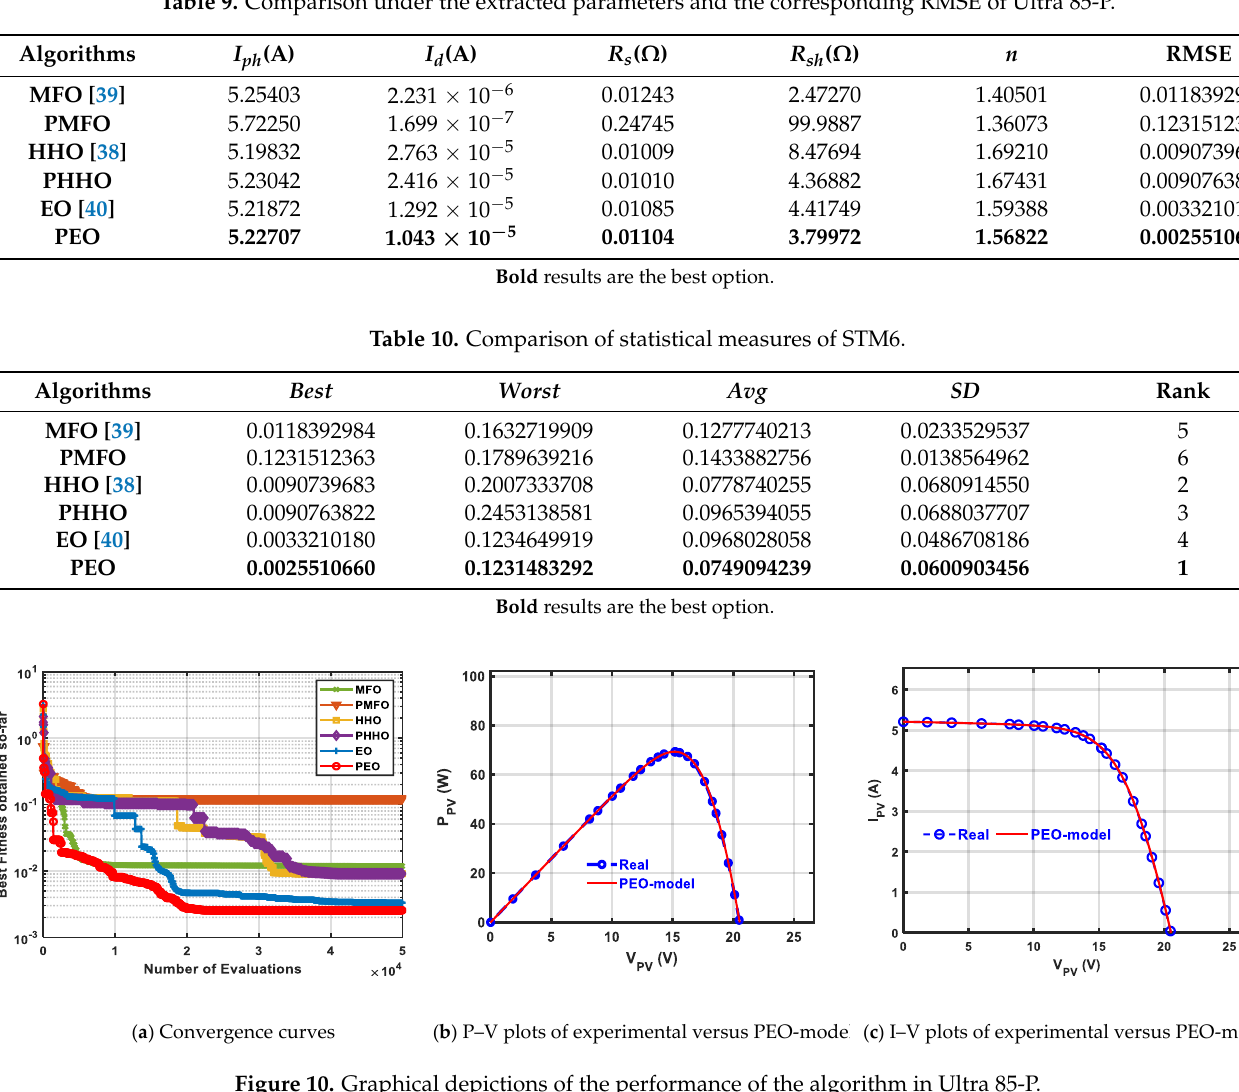
Table 9. Comparison under the extracted parameters and the corresponding RMSE of Ultra 85-P.